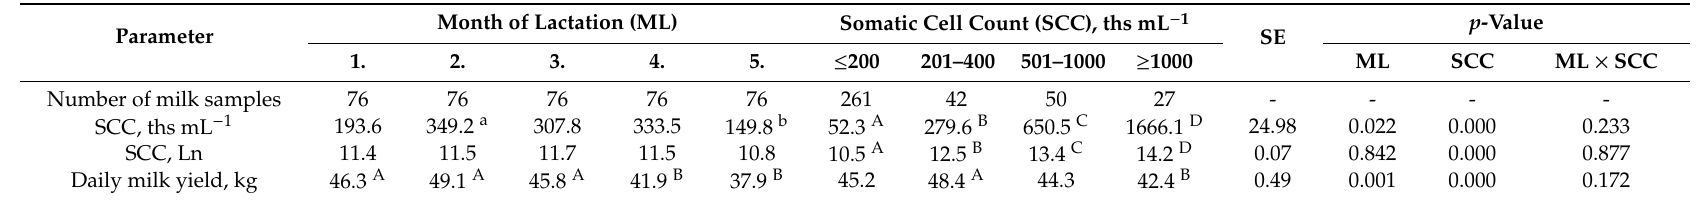
Table 1. E ff ects of the month of lactation and the udder health of cows on the average daily milk yield.